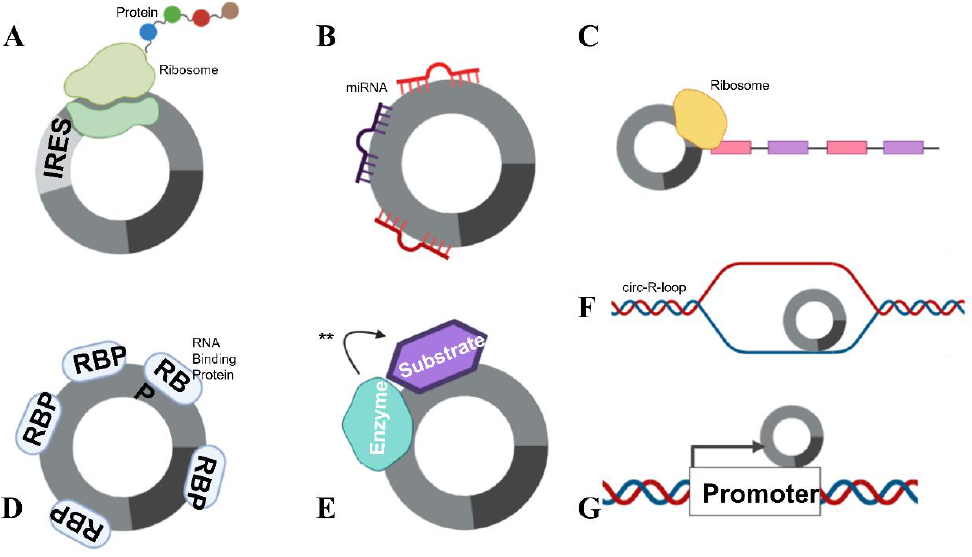
Figure 3. circRNA functions. circRNAs are able to complete numerous roles: ( A ) Translation can occur in the presence of an IRES. ( B ) circRNAs can function as miRNA sponges, by “mopping up” miRNAs and preventing their actions. ( C ) mRNA traps (inhibits translation) by sequestering the translation start site on mRNA. ( D ) circRNAs are also able to bind proteins, including RBPs and ( E ) enzyme– substrate complexes, to facilitate actions (denoted with **) such as phosphorylation, ubiquitylation and acetylation. ( F ) circRNAs can form circ-R-loops with DNA and impede transcription, facilitating DNA breaks. ( G ) circRNAs can also influence the host promoter region, altering DNA replication and